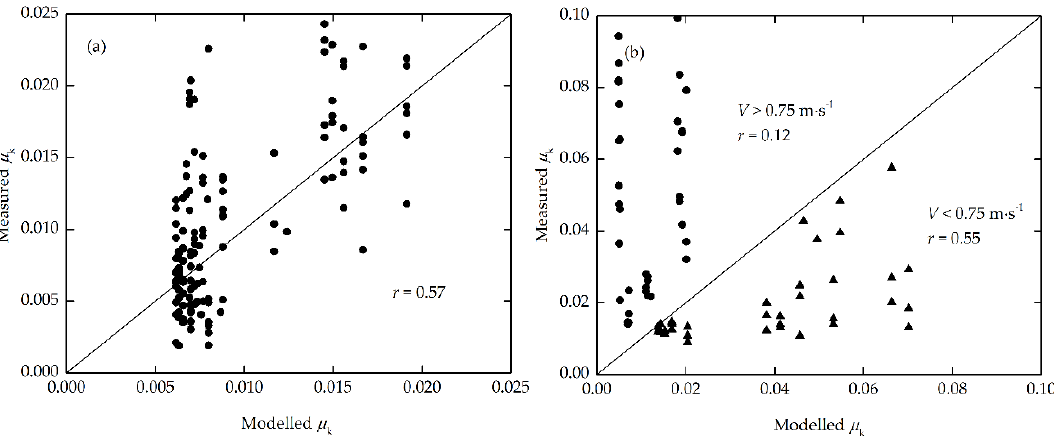
Figure 13 . The approximate comparisons between experimental data and estimation of model [43] for ( a ) ice-ice friction and ( b ) steel-ice friction. The correlation coefficient between measured and modelled values was 0.84 for ice–ice friction. For steel–ice friction, the model underestimated and overestimated the experimental data at velocity greater and lower than 0.75 m·s −1 respectively, and the correlation coefficients were 0.12 and 0.55 respectively.